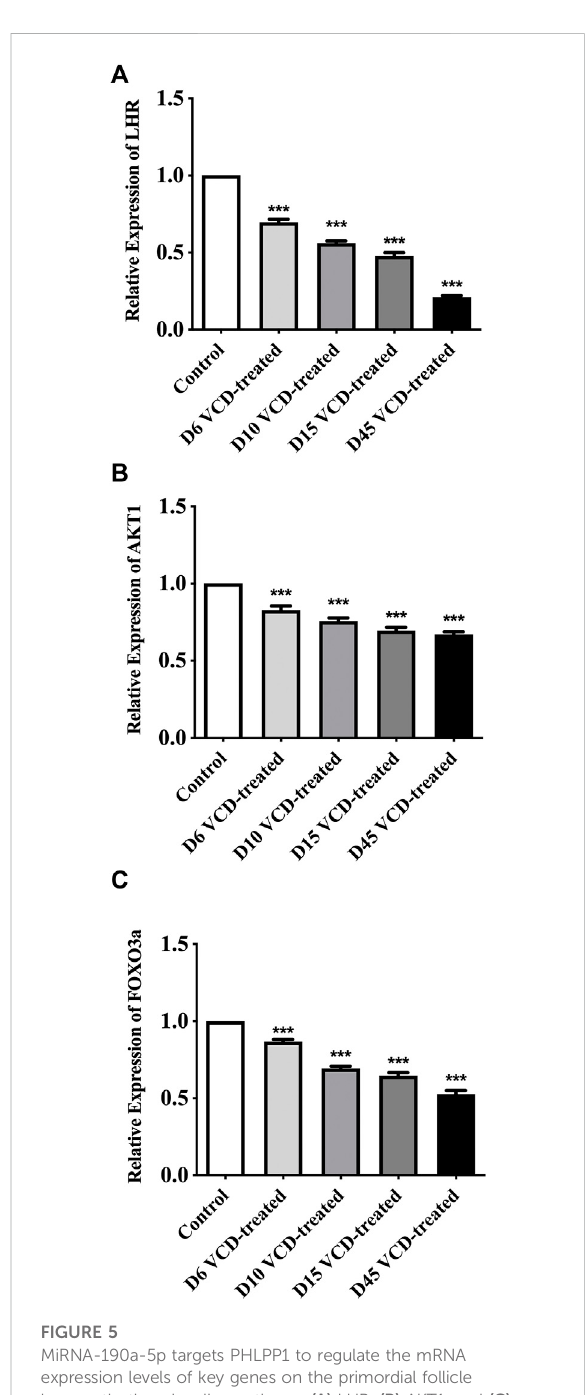
FIGURE 5 MiRNA-190a-5p targets PHLPP1 to regulate the mRNA expression levels of key genes on the primordial follicle hyperactivation signaling pathway. (A) LHR, (B) AKT1, and (C) FOXO3a mRNA expression during the VCD treating process (D6, D10, D15 and D45) in rat ovaries tissues were determined by qRT-PCR analysis. Data are summarized and presented as mean ± SEM from three independent experiments. *** p ＜ 0.001 vs.